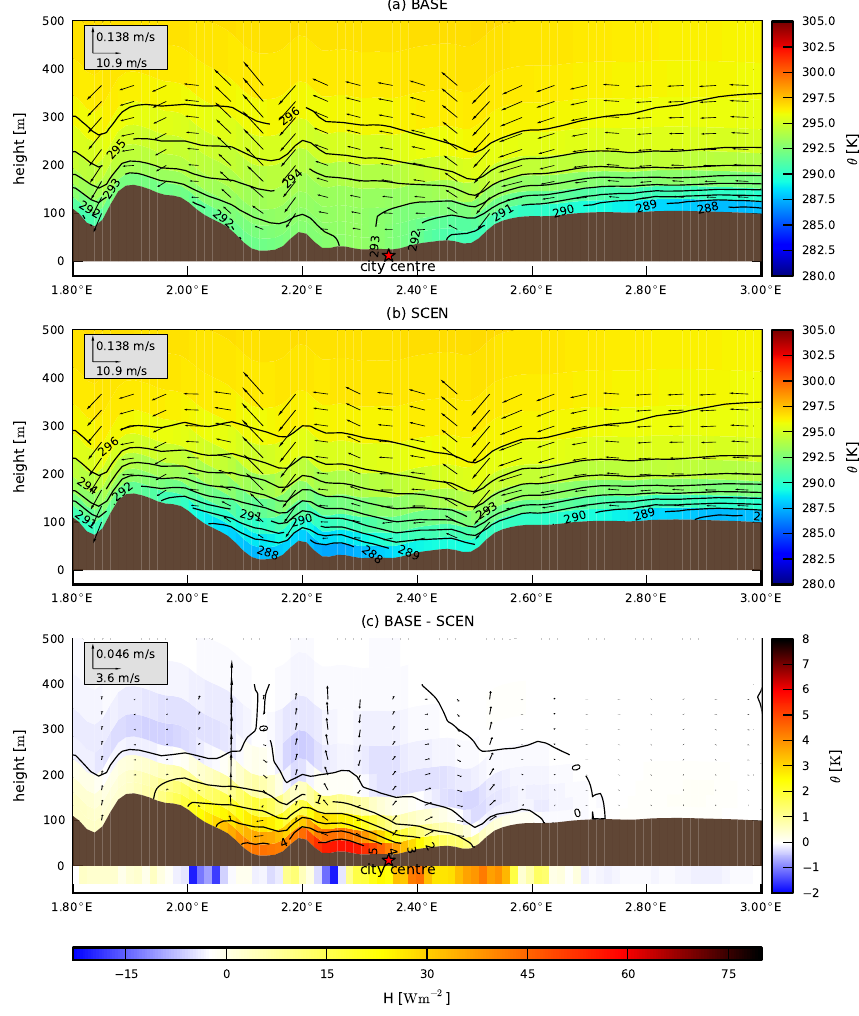
Fig. 10. 5-day averaged vertical profiles of potential temperature over Paris at 23:00UTC for the base run (a), scenario run (b) and their difference (c) . The differential surface heat flux is added to the bottom of (c)